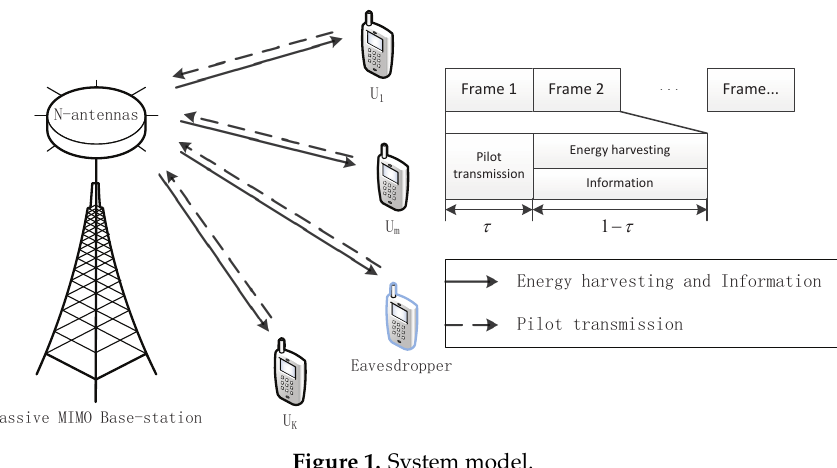
Figure 1. System